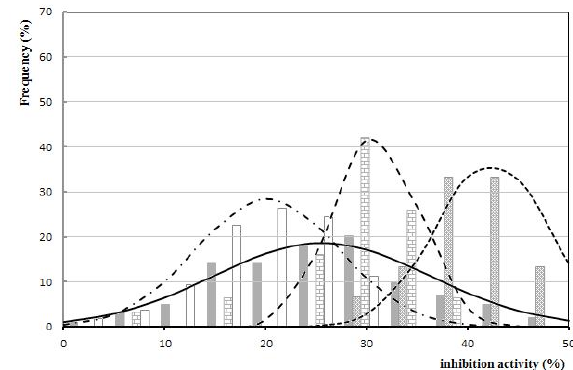
Figure 12: Distribution of inhibitory activity to elastase in oat extracts expressed as % of inhibitory activity (solid column and solid line – complete set, r 2 = 0.927, bracket column and dash line – minor red subset, r 2 = 0.990, dots column and dash-and-dot line – major green subset, r 2 = 0.968, empty column and dots line – major blue subset, r 2 = 0.980, the mentioned colors correspond to the colors in Fig. 7 and Fig.